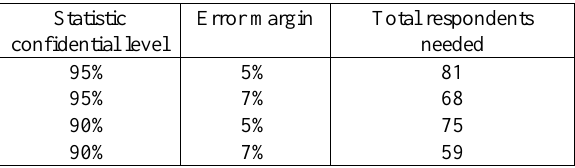
Table 1. Responses needed for statistic accuracy levels